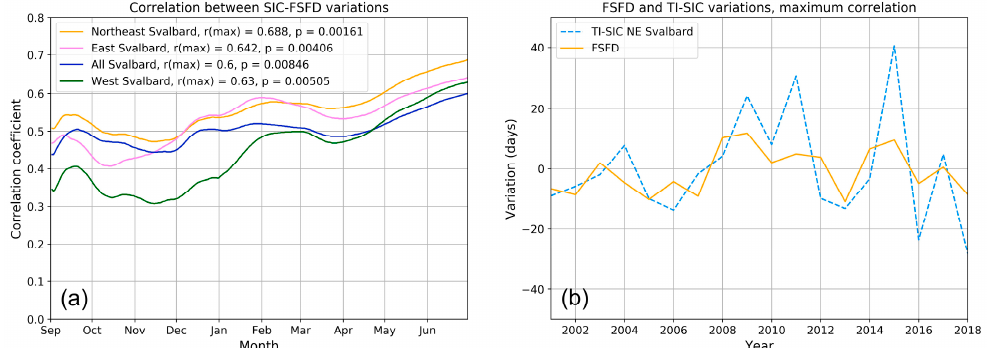
Figure 14. ( a ) Correlation between TI-SIC and FSFD variations averaged over Nordaustlandet, calculated for SIC integrated from 1 September of the previous year to each consecutive day of year until 30 June of the following year, for the four sea ice regions. The maximum correlation coefficients for each sea region and the associated p-values are stated in the legend. ( b ) Time series of the TI-SIC variations for the sea region northeast of Svalbard that produced maximum correlation with the time series of FSFD variations over Nordaustlandet.